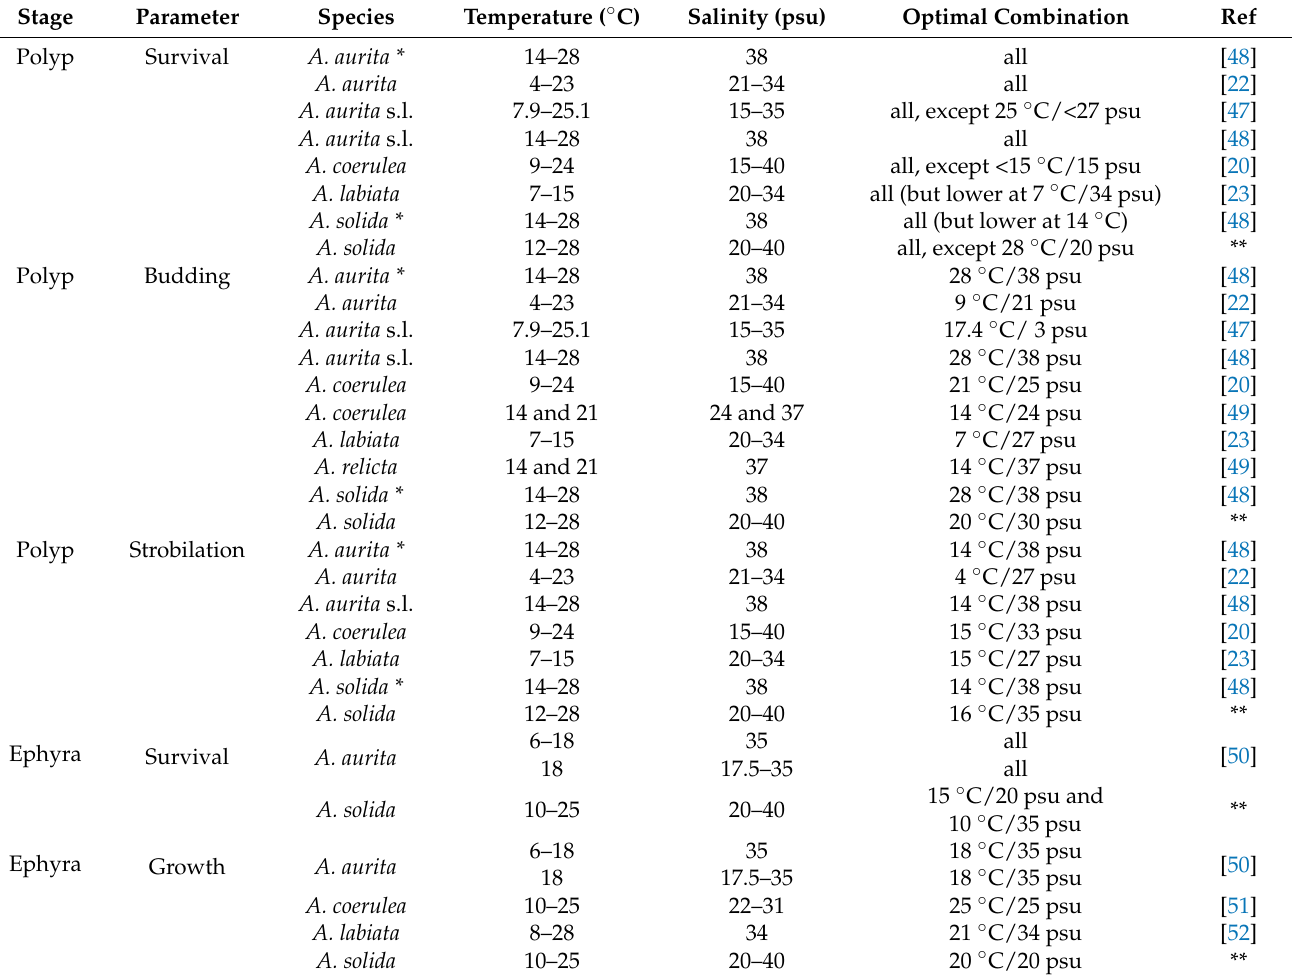
Table 3. Comparison of optimal temperature and salinity conditions for polyp and ephyra survival and asexual reproduction and ephyra growth in different Aurelia species, based on